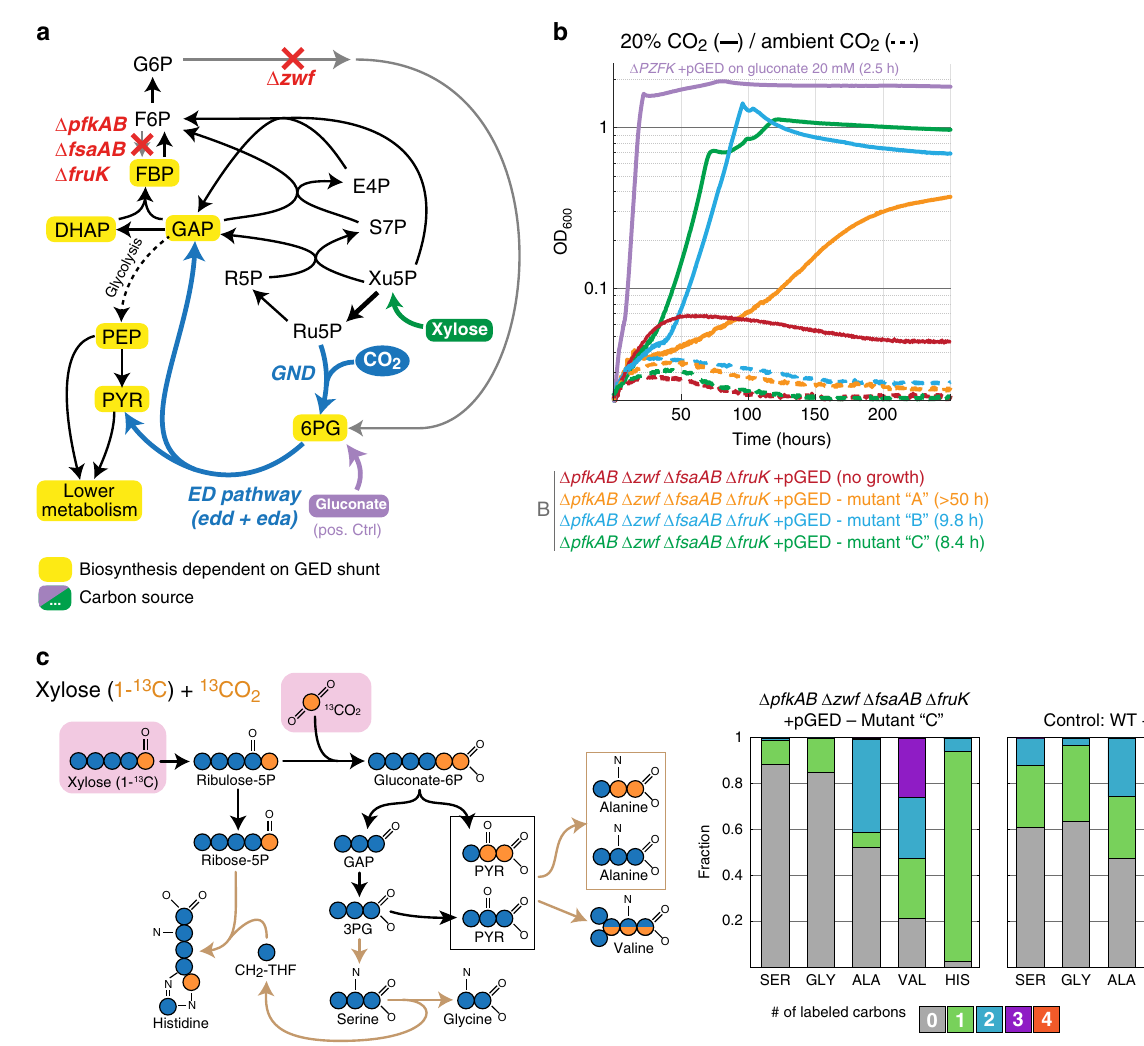
Fig. 4 Activity of the GED shunt in a Δ PZF strain that enables a smooth transition into a GED cycle. a Design of the Δ PZF ( Δ pfkAB Δ zwf Δ fsaAB Δ fruK) selection scheme. Xylose can be assimilated only via the activity of the GED shunt, where the biosynthesis of most biomass building blocks is dependent on the pathway (marked in yellow). Growth on gluconate (violet) is not dependent on reductive carboxylation via Gnd and thus serves as a positive control. Reaction directionalities are shown as predicted by fl ux balance analysis. b Growth on xylose upon overexpression of gnd , edd , and eda (pGED) was achieved only after adaptive evolution and was dependent on elevated CO 2 concentration. Values in parentheses indicate doubling times. Curves represent the average of technical quadruplicates, which differ from each other by <5%. Growth experiments were repeated independently three times to ensure reproducibility. c 13 C-labeling experiments con fi rm the operation of the GED shunt (mutant ‘ C ’ ). Cells were cultivated with xylose (1- 13 C) and 13 CO 2 . Observed labeling fi ts the expected pattern and differs from that of a WT strain cultured under the same conditions. Results from additional labeling experiments are shown in Supplementary Fig. 3. 3PG 3-phosphoglycerate, ALA Alanine, GAP glyceraldehyde-3-phosphate, GLY Glycine, HIS Histidine, PYR pyruvate, SER Serine, VAL Valine. Source data underlying b and c are provided as a Source Data fi